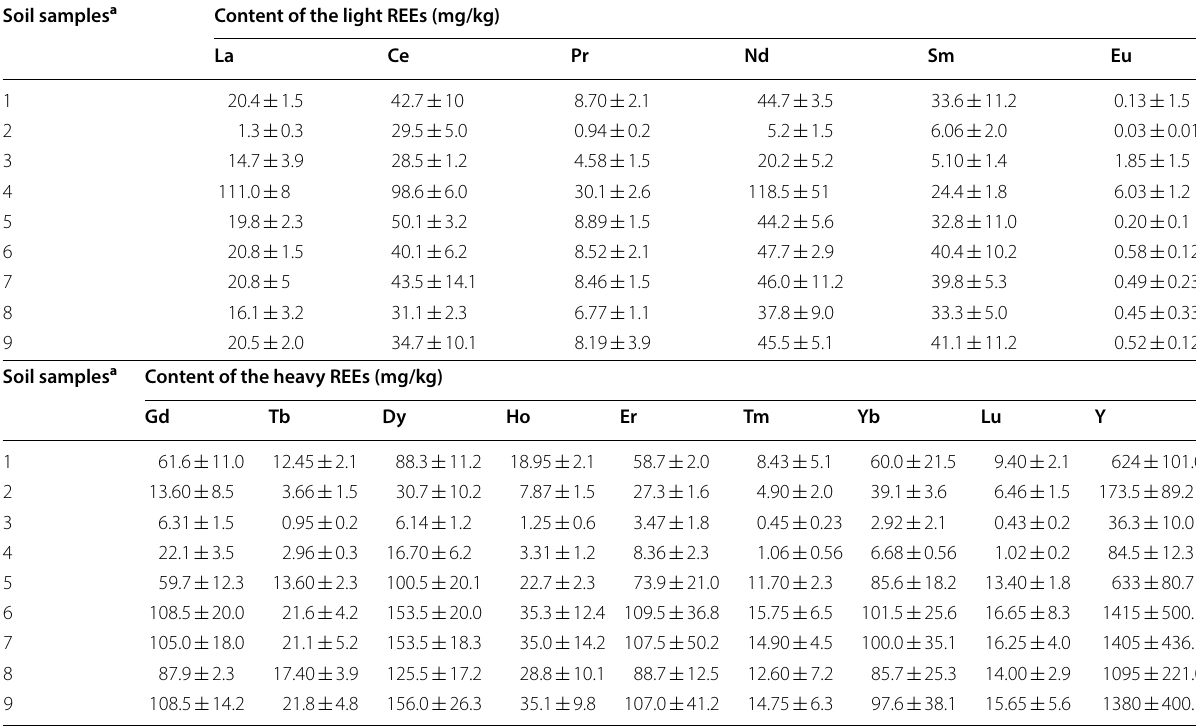
a Samples 1–5 were from the mined spot, where the soil is high in quartz and gray-white in color. Samples 6–9 were obtained from the unmined spot, where the soil is red topsoil after removing withered leaves